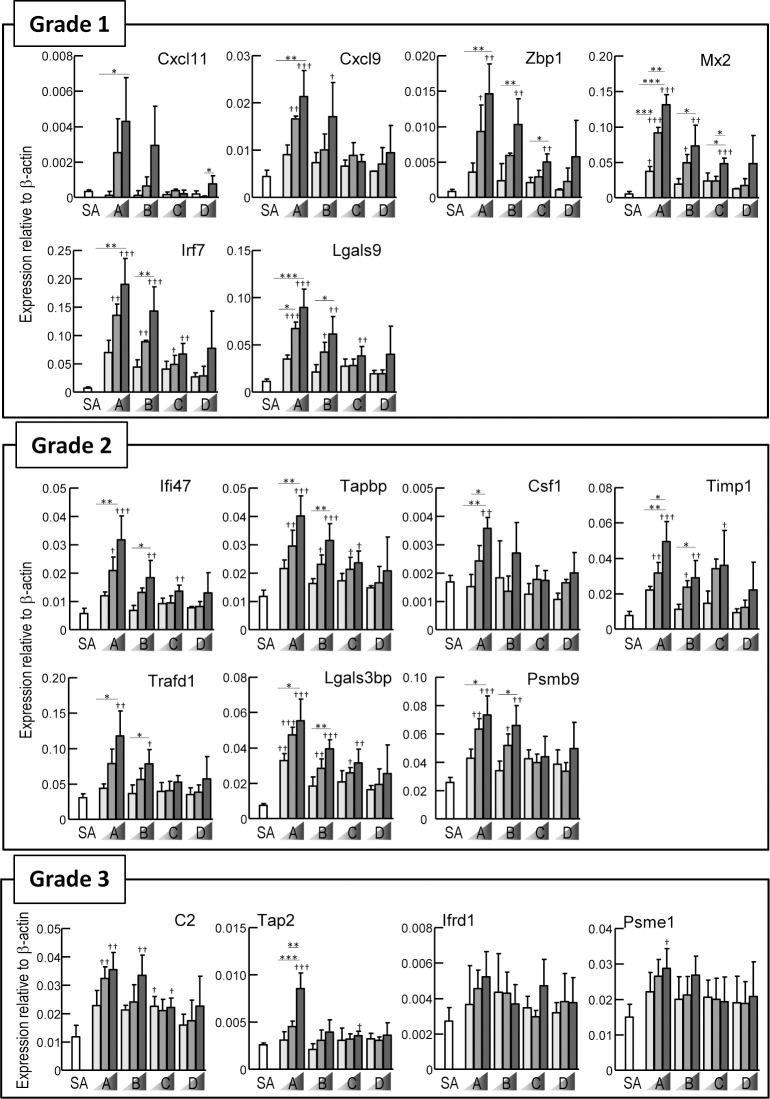
Gene expression analysis of HA bulk material treated rats.One lung lobe was obtained from rats treated with various concentrations of HA bulk material in Fig 1, and expression levels of genes were analyzed by bDNA-RNA, and were shown relative to β-actin. Same data was used in SA of Fig 3 and 0 U/ml RE of Fig 2. Three rats per group were used. Values are expressed as mean ± S.D. * P < 0.05, ** P < 0.01, *** P < 0.001. † P < 0.05 versus SA, †† P < 0.01 versus SA, ††† P < 0.001 versus SA.